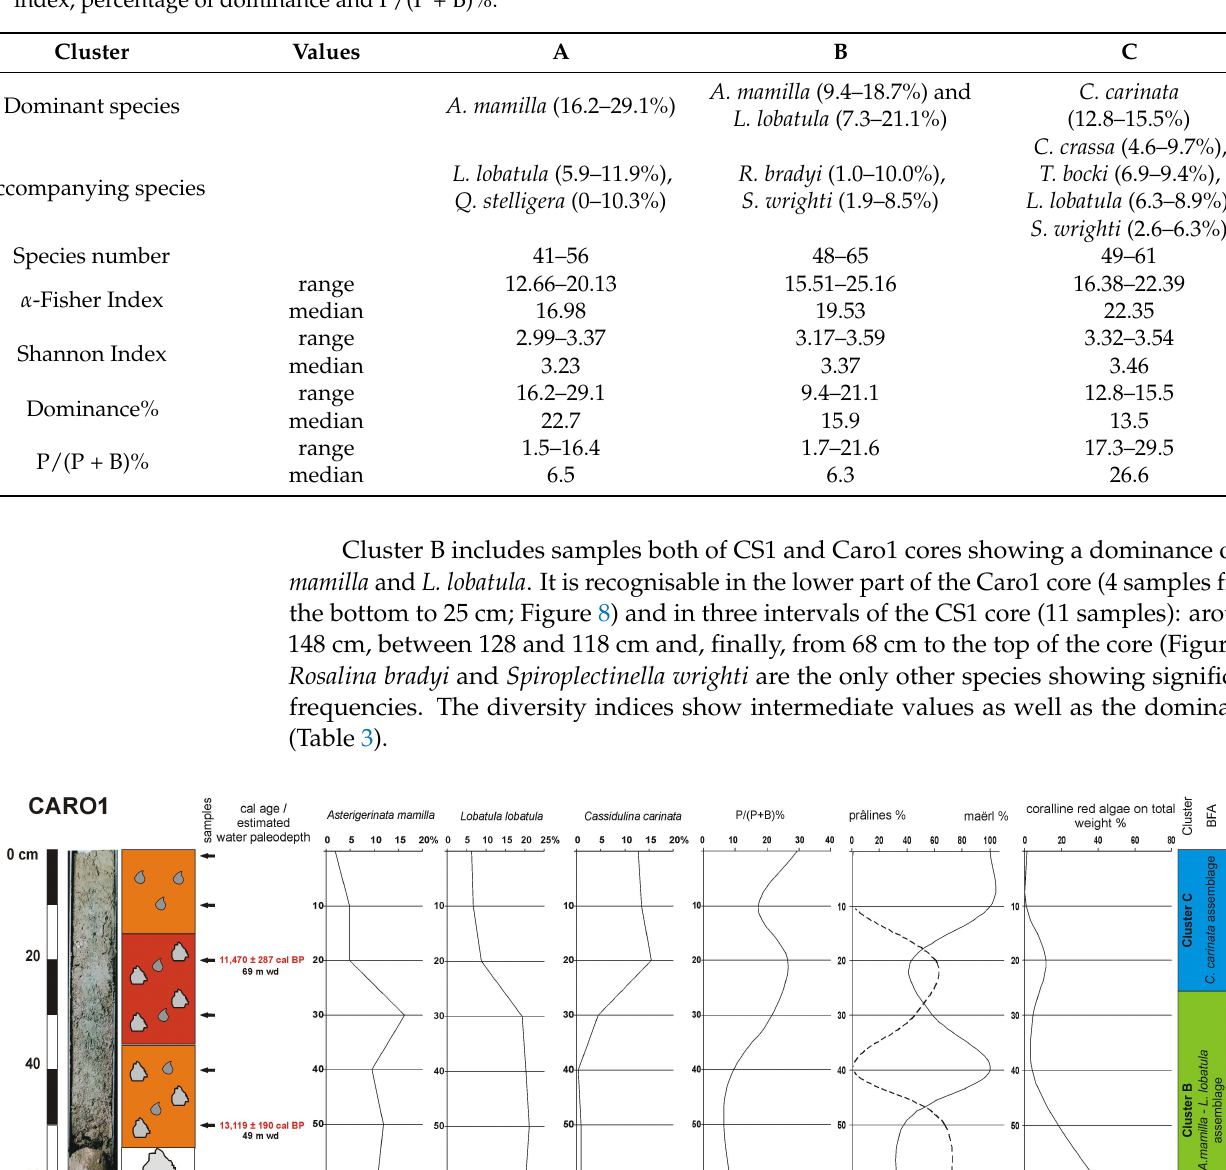
Table 3. Main features of 3 clusters: dominant species, accompanying species, species number, α -Fisher index, Shannon index, percentage of dominance and P/(P + B)%.